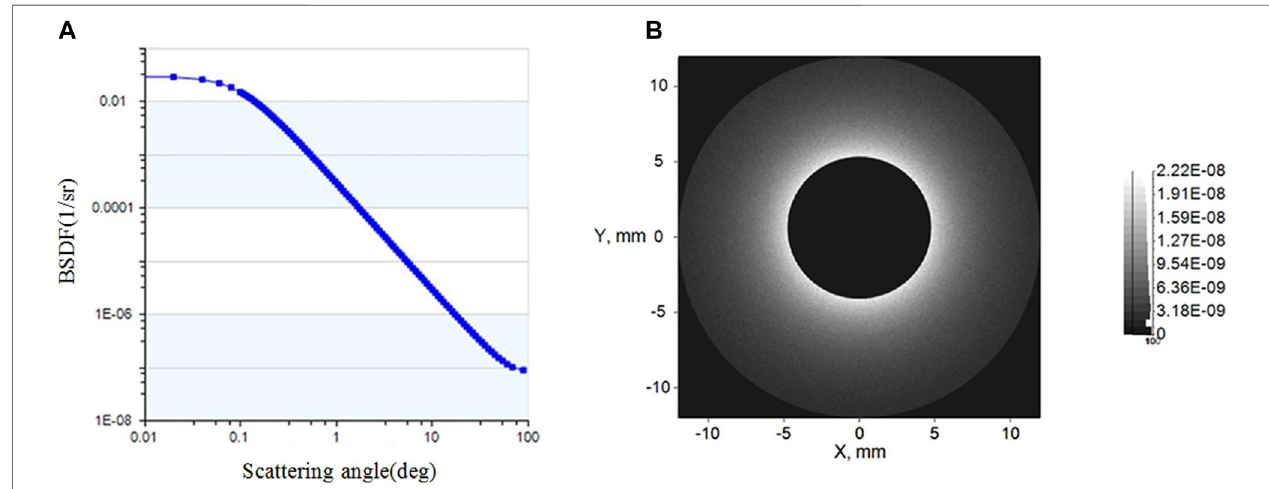
FIGURE9| Scatteredstray-lightsimulationresultsfromscratchesofM1at700 nm. (A) BSDFcurveasafunctionofthescatteringangle. (B) Stray-lightdistribution at the focal plane.